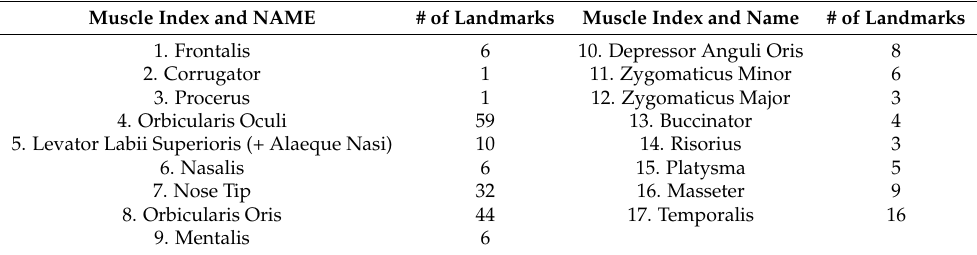
Figure 3. Facial muscles [52] ( left ), grouped from facial landmarks ( middle ) and indexes and muscle names ( right ). Adapted with permission from [52]. 2022, reineg. Table 1. The 478 facial landmarks in the defined facial muscle groups.